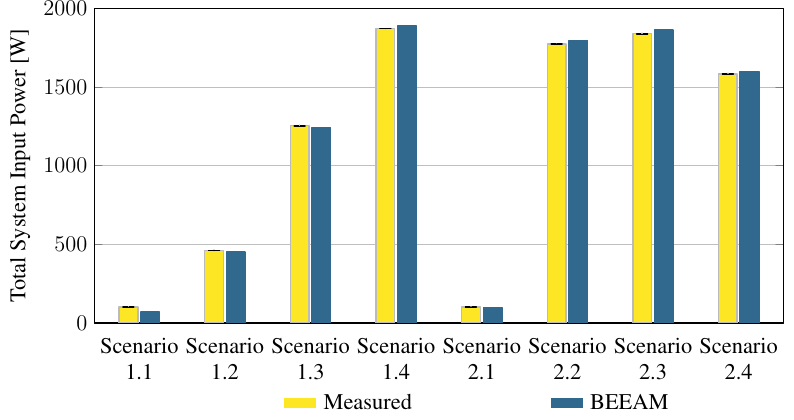
Figure A8. Predicted versus measured total system input power, Scenarios 1 and